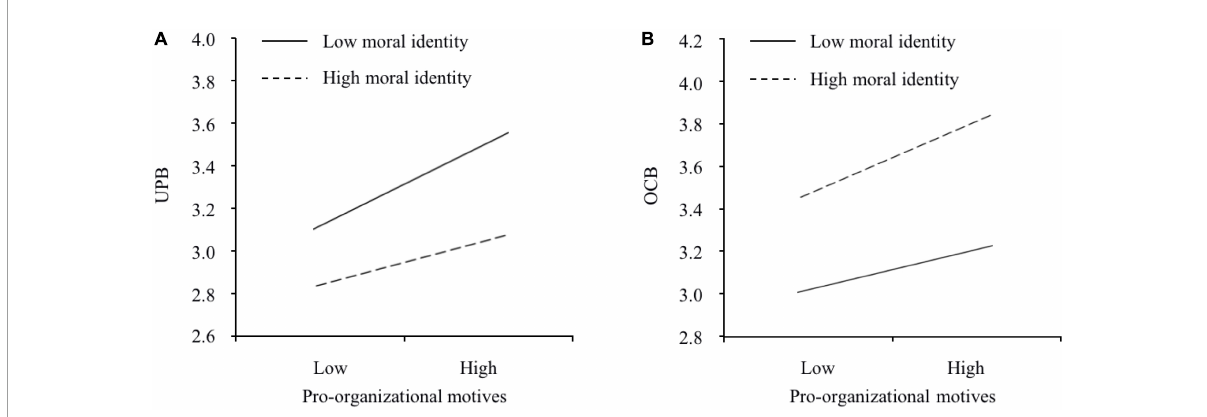
FIGURE2 The moderating effects of moral identity on (A) the relationship between pro-organizational motives and UPB and (B) the relationship between pro-organizational motives and